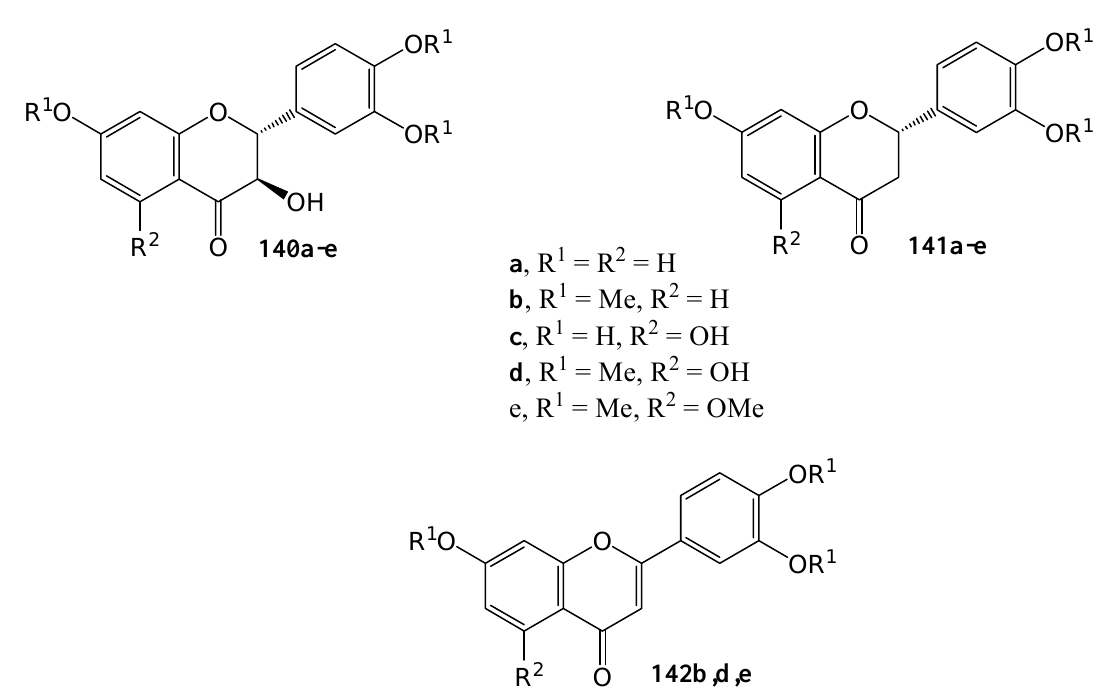
Figure 5. Flavanones and flavone obtained from